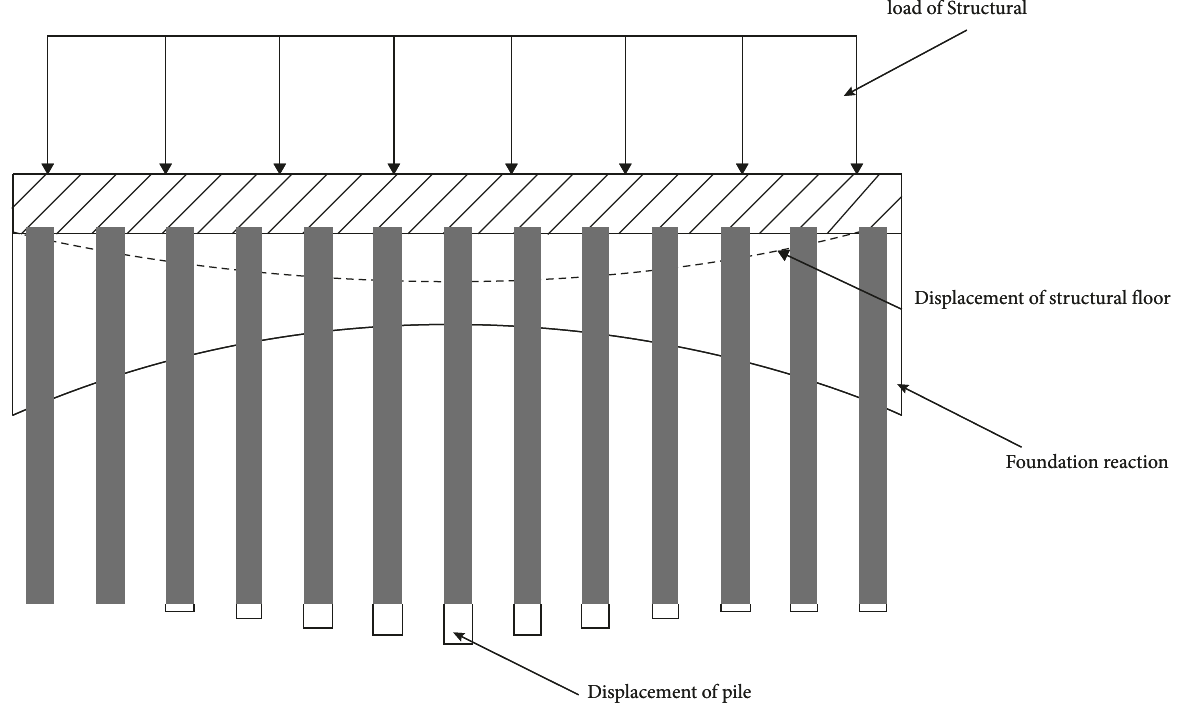
Figure 17: Schematic diagram of deformation characteristics of pile group stress